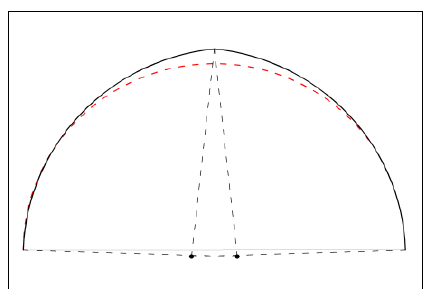
Figure 1. Geometric trace of stellar vault in plan